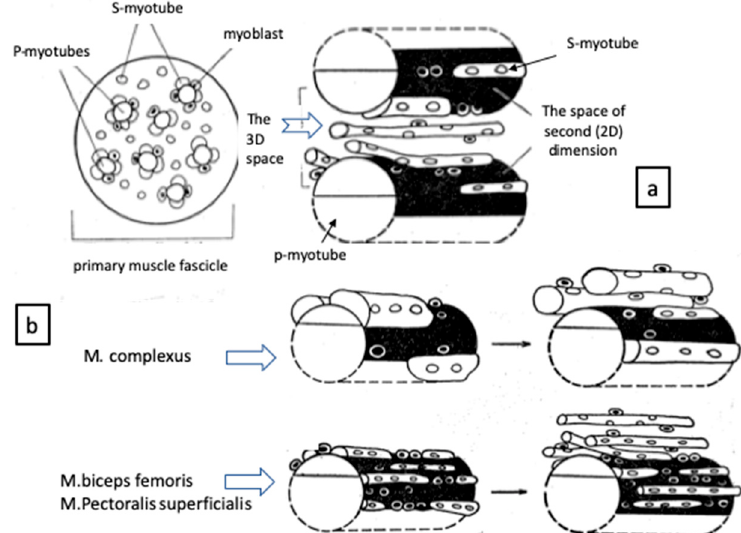
Figure 2. Schematic model indicating the stereographic structure of the relationship among primary myotube (p-myotube), secondary myotube (s-myotube) and myoblasts proliferating within a primary muscle fascicle ( a ). The s-myotubes take gradually the 2D space on the surface of p-myotubes. They separate from p-myotubes and then occupy the 3D space within a primary muscle fascicle (a) (right). ( b ) A comparison of myotube formation between complexus and other muscles. Note that a remarkable growth of s-myotubes in complexus muscle loses both 2D and 3D spaces rapidly to develop around p-myotubes compared to other muscles [22,24].